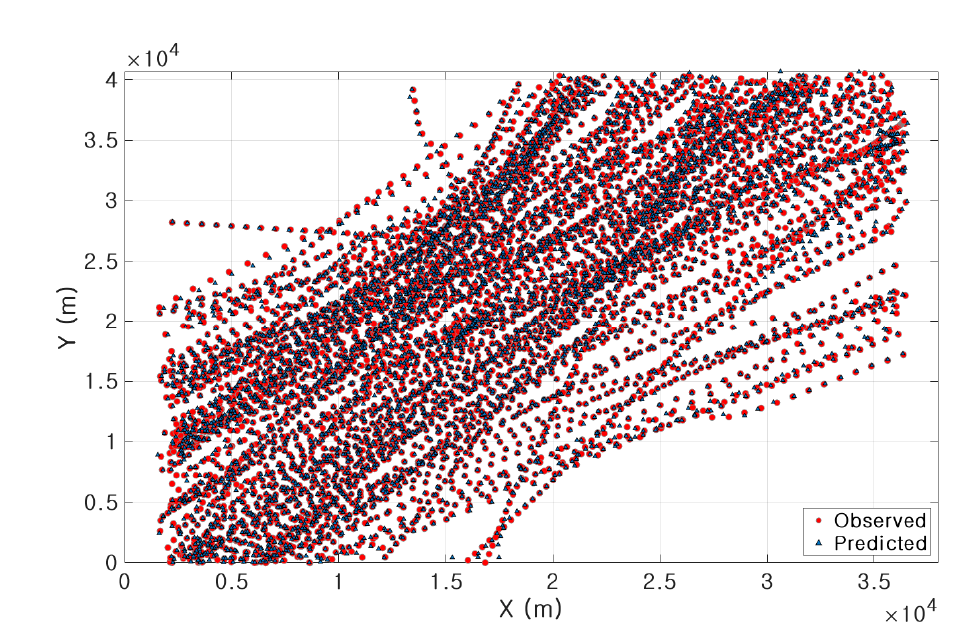
( c ) Predicted trajectory for group A using LSTM Figure 8.